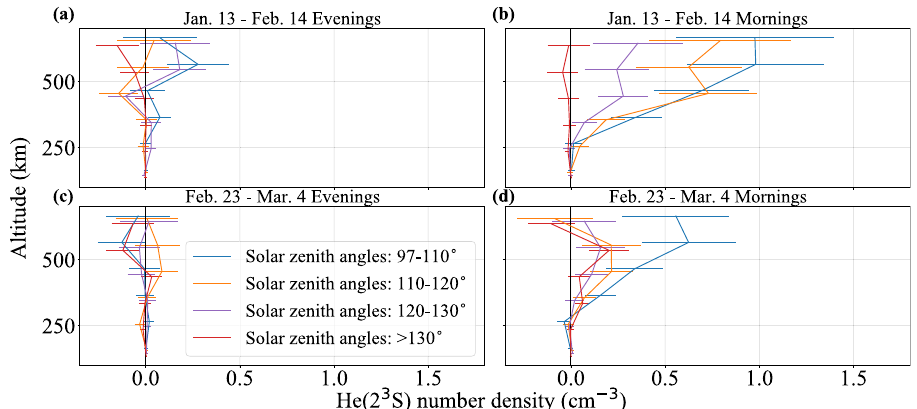
points represent vertical bins of 100km and are plotted with ±5 – 15km vertical offsets to avoid overlap. The error bars represent 1 σ uncertainties, as described in the Methods